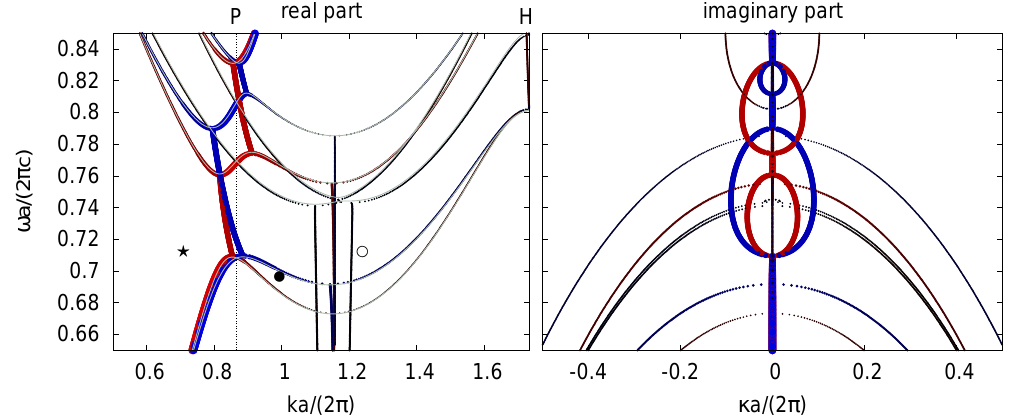
{? 3 « 1 . 15 ( k “ 2 { 3 ˆ p 1 , 1 , 1 q T )